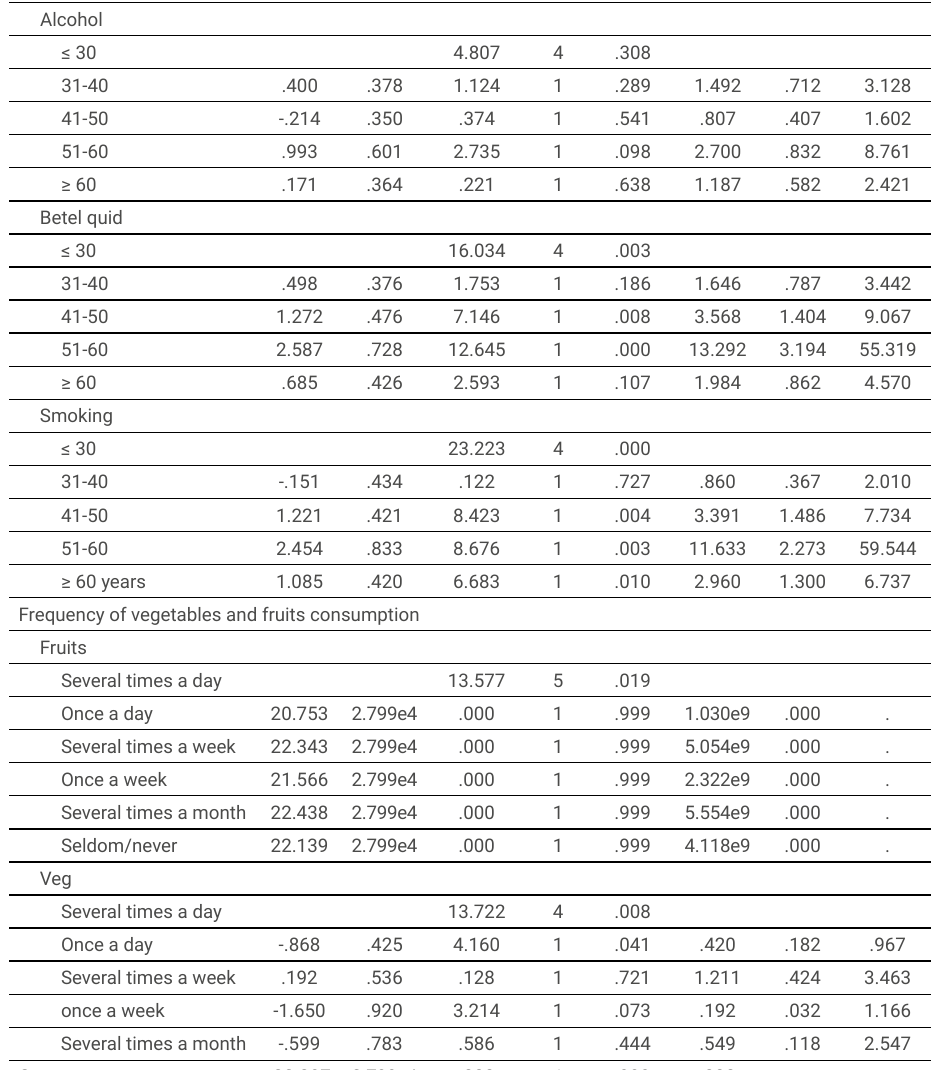
95.0% ci for or Lower